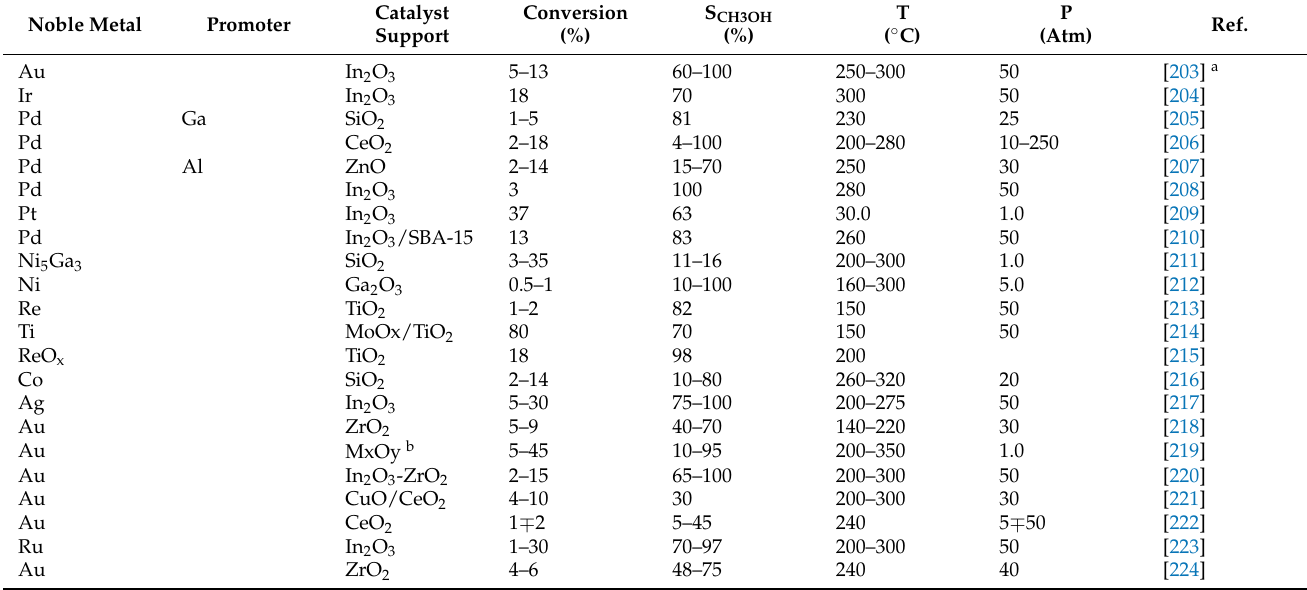
Table 6. A comparative summary of different noble metals and rare earth supported catalysts studied in the carbon dioxide hydrogenation process to produce